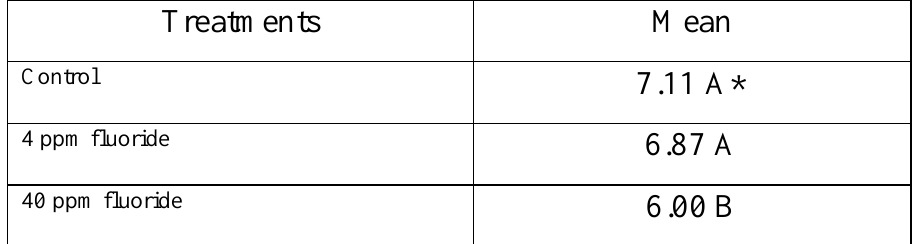
Table(1): Effect of fluoride on flavor scores of Cheddar cheese on both days